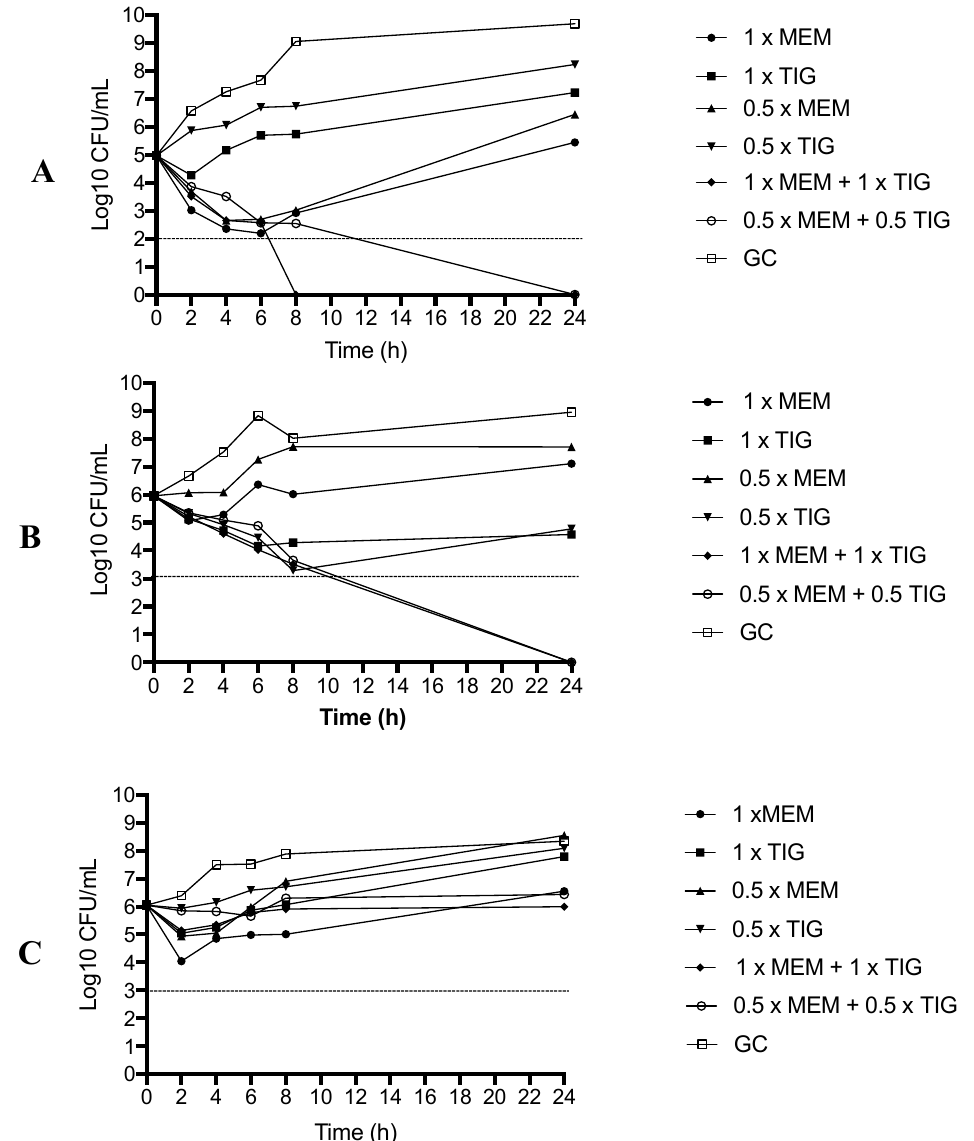
Figure 3. Killing studies of combination without COL against COL-S (2A), COL-LR (2B) and COL-HR (2C) CR-Ab strains. MEM: meropenem; TIG: tigecycline; GC: growth control. Dashed line represents bactericidal activity that occurred at any time point compared to the initial bacterial inoculum.